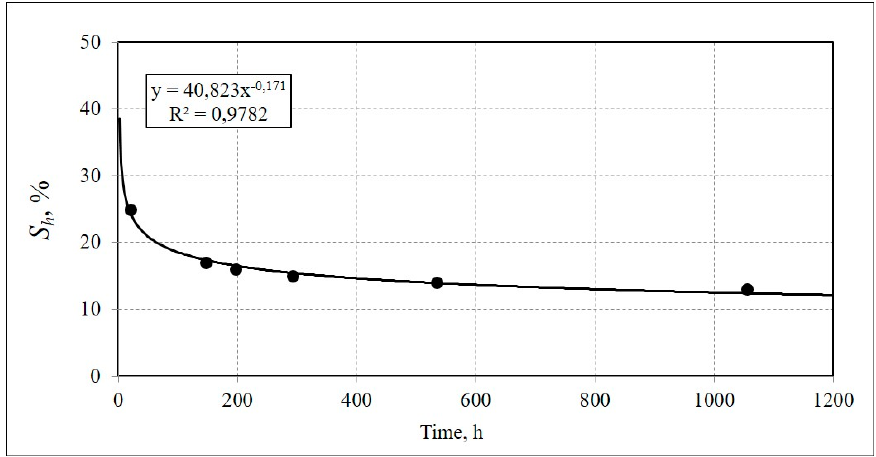
Figure 5. Time-dependent hydrate saturation ( S h ) of frozen fine sand-1 at − 6 °C and 0.1 MPa. Black dots are experimental data; solid line is a trend line of exponential approximation.